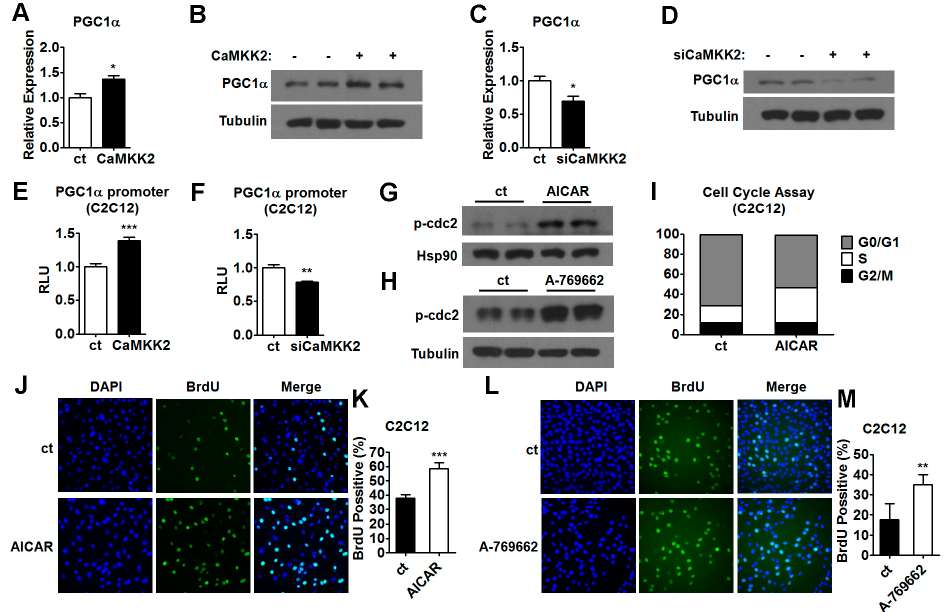
Figure 6. The mechanism of AMPK inhibits C2C12 myoblasts proliferation and differentiation. ( A ) Quantitative RT-PCR analysis of PGC1 α mRNA levels in C2C12 myotubes transfected with CaMKK2 plasmids ( n = 3); ( B ) Representative western blot showing the PGC1 α protein levels in the C2C12 cells transfected with CaMKK2 plasmids; ( C ) Quantitative RT-PCR analysis of PGC1 α mRNA levels in C2C12 myotubes transfected with siCaMKK2 ( n = 3); ( D ) Representative western blot showing the PGC1 α protein levels in the C2C12 cells transfected with siCaMKK2; ( E ) PGC1 α transcriptional activity in C2C12 cells co-transfected with CaMKK2 and PGC1 α promoter plasmids ( n = 3); ( F ) PGC1 α transcriptional activity in C2C12 cells co-transfected with siCaMKK2 and PGC1 α promoter plasmids ( n = 3); ( G , H ) Representative western blot showing the p-cdc2 Tyr15 protein levels in C2C12 myoblasts treated with 0.25 mM AICAR ( A , G , I ) and 80 μ M A-769662 ( H ) for 48 h; ( I ) Flow cytometric analysis of C2C12 myoblasts treated with 0.25 mM AICAR for 48 h during proliferation. Percentage of cells in G1, S and G2 phases were analyzed ( n = 3); ( J , L ) DNA synthesis in C2C12 cells treated with 0.25 mM AICAR (J) or 80 μ M A-769662 ( L ) by BrdU incorporation assay; ( K , M ) Quantification of the BrdU positive cells ( n = 3) in C2C12 cells treated with 0.25 mM AICAR ( K ) or 80 μ M A-769662 ( M ) by BrdU incorporation assay. Experiments were repeated at least twice. Means ± SEM (error bars) are shown. *, p < 0.05; **, p < 0.01; ***, p < 0.001. It has been shown that CaMKK2 can form a complex with and activate AMPK, while a K193A mutation in CaMKK2 disrupts the binding to AMPK, but not CaMKIV [34]. We found that this CaMKK2 K193A mutant (CaMKK2 mut) could not activate AMPK in C2C12 cells (Figure S7A). More interestingly, we found that overexpression of CaMKK2 mut could neither lead to cell cycle retardation nor inhibit myoblast differentiation C2C12 cells (Figure S7B–D). These results indicated that the binding of CaMKK2 to AMPK and the activation of AMPK might be required for the regulation of proliferation and differentiation by CaMKK2 in C2C12 muscle cells.